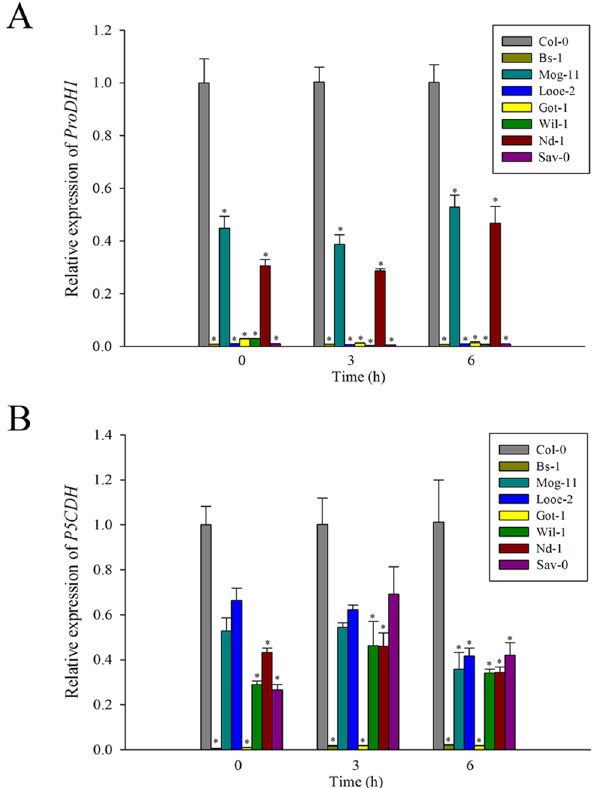
Fig 6. Expression analysis of genes related to proline degradation by qRT-PCR. The transcript levels of (A) ProDH1 and (B) P5CDH in Col-0 and the selected accessions exposed to 100 mM NaCl for 0, 3 and 6 h. Values given as mean ± SE ( n = 3). Significant differences from Col-0 accession at the same time point are indicated by * ( P < 0.05).